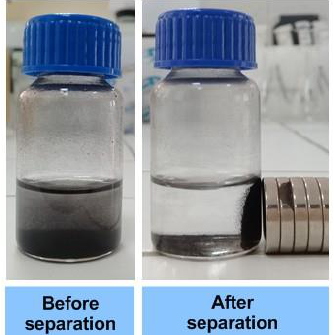
Figure 8. Magnetic separation of the Cu-Fe 3 O 4 -PAC catalyst with an external magnetic field.